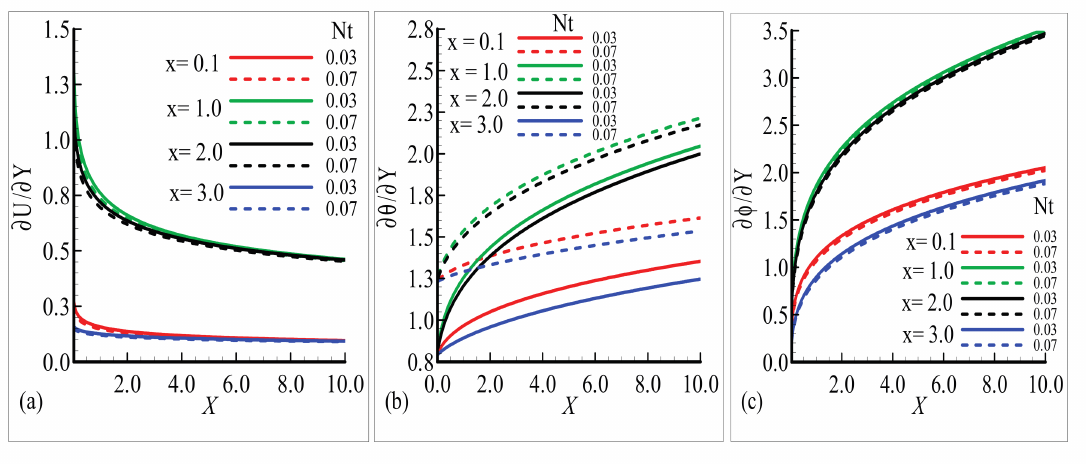
∂φ ∂θ ( c ) , ( b ) ∂ Y , and ∂ Y versus, Nt when Sc Y